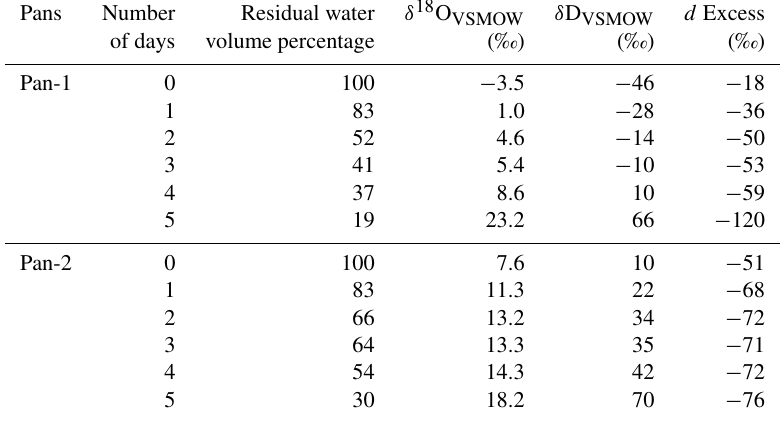
Table 1. Results from the pan evaporation experiments.